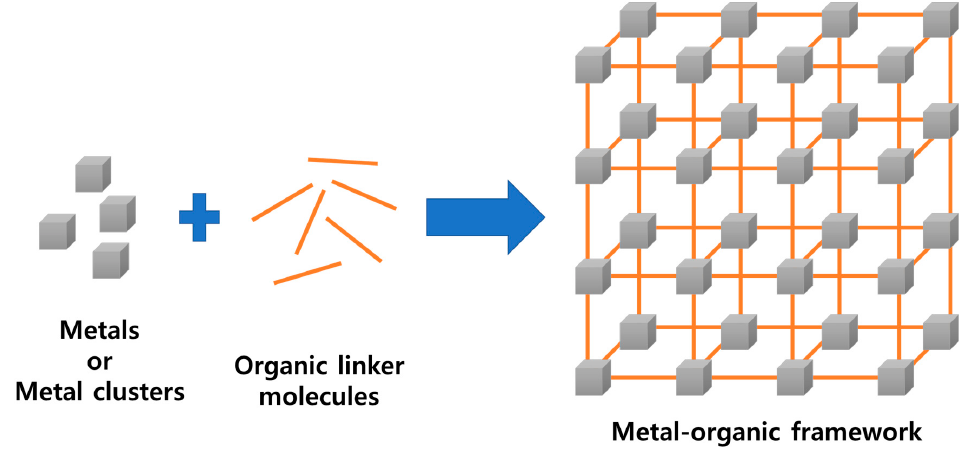
Figure 1. Schematic of the metal-organic framework (MOF) structure.